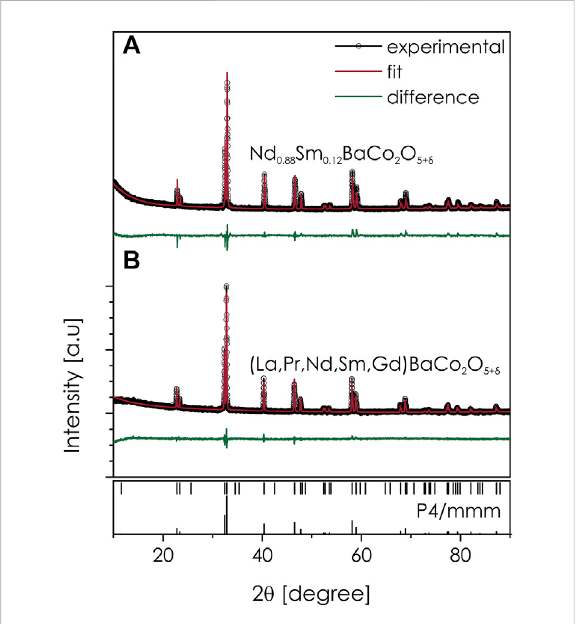
FIGURE 1 DiffractogrammeasuredatRTfortheas-calcinedpowdersof Ba(La,Pr,Nd,Sm,Gd)Co 2 O 5+ δ and Nd 0.88 Sm 0.12 Co 2 O 5+ δ , together with Rietveld re fi